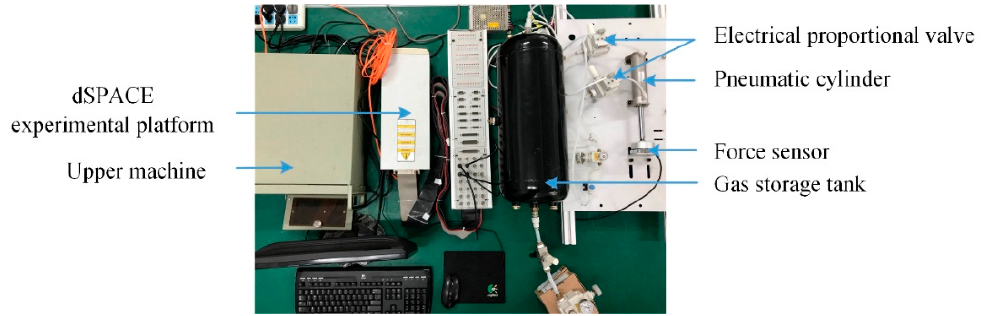
Figure 13. Experimental platform of pneumatic servo control system.